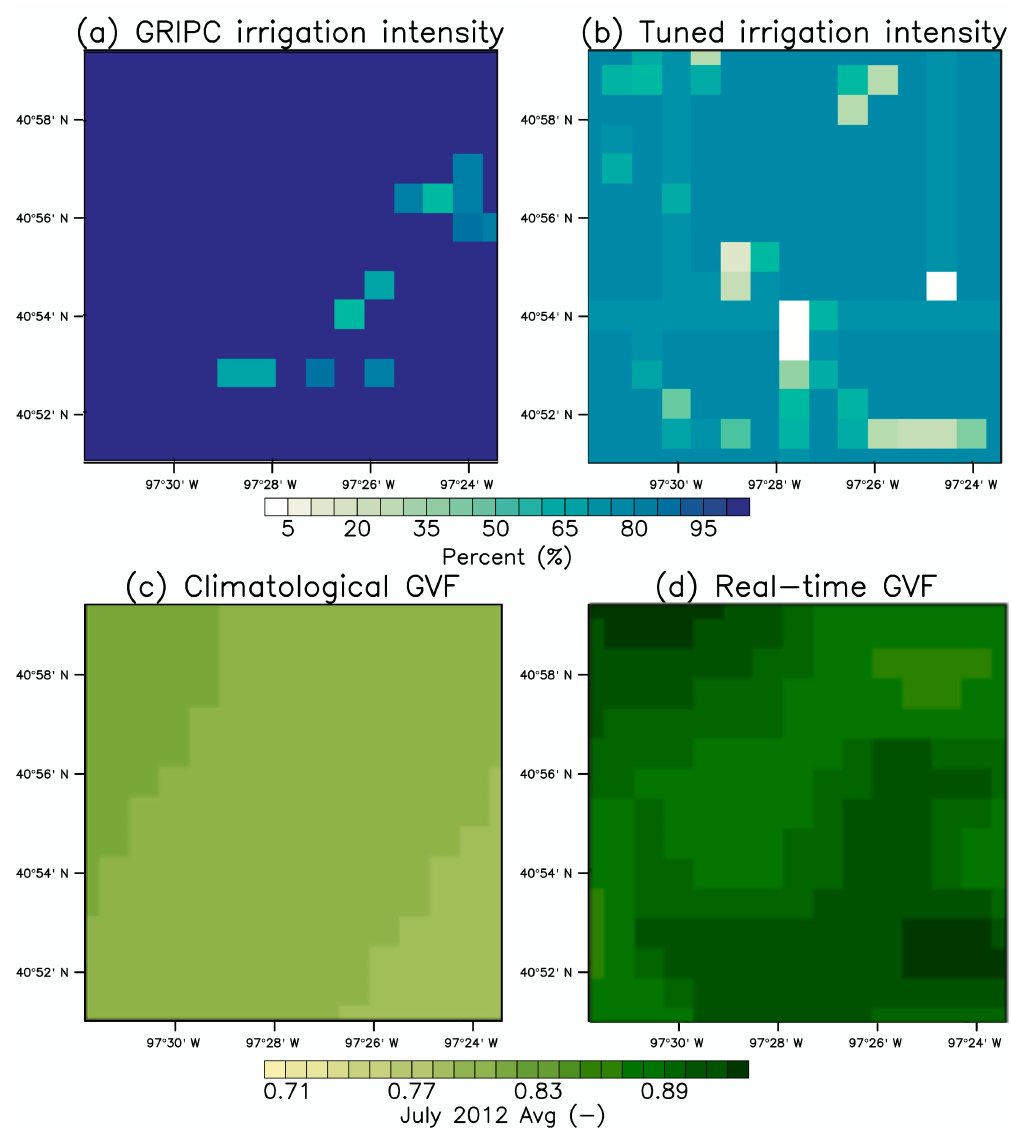
Figure 1. (a) The global rain-fed, irrigated, and paddy croplands dataset (GRIPC) irrigation intensity (percent) given by Salmon et al. (2015) used in the Standard and SPoRT simulations and (b) the observationally tuned irrigation intensity used in the Tuned simulation. The spotty nature of the Tuned simulation indicates where irrigation intensity has been reduce due to the presence of roads, wetlands, rain-fed fields, and/or buildings. Also shown is the average greenness vegetation fraction (unitless) in July 2012 given by (c) NCEP climatology used in the Standard and Tuned simulations and (d) the SPoRT real-time dataset used in the SPoRT